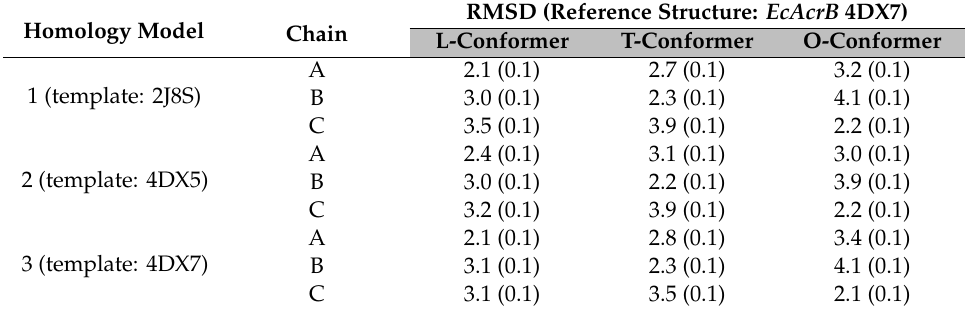
Table 1. Cross-RMSD of each chain of S TmAcrB G288D , with respect to every conformer of the Ec AcrB crystal structure 4DX7. For each model, the calculation was performed on the last 140 ns of the production run (see Materials and Methods); the reported values correspond to the average RMSD and its standard deviation in the Loose (L), Tight (T) and Open (O) conformer. Only the C α atoms were considered for this calculation.